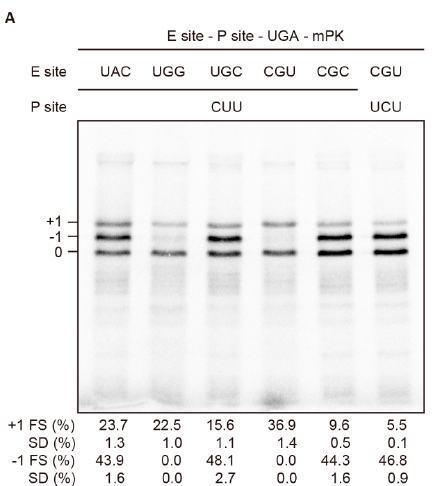
Figure 5. An identical nucleotide bridging E- and P- sites facilitates non-canonical − 1 frameshifting. SDS-PAGE analysis of in vitro radioactivity based frameshifting assays of constructs with E-site or P- site mutagenesis. Calculated -1 and +1 PRF efficiencies displayed are means ± SD of three independent experiments.